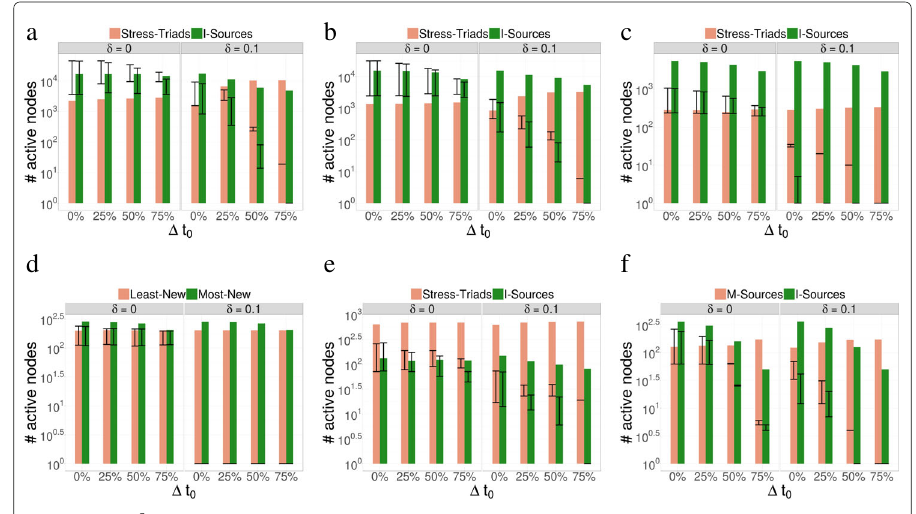
Fig. 12 spC - F 2 DLT : Spread, number of switched users, and number of switches (log scale) by varying start-delay ( (cid:10) t 0 ) of the “good” campaign (second bars), for δ = 0 (left-most bar groups) and δ = 0.1 (right-most bar groups), k = 50. a Epinions. b Slashdot. c Wiki-Conflict. d Wiki-Conflict. e Wiki-Vote. f